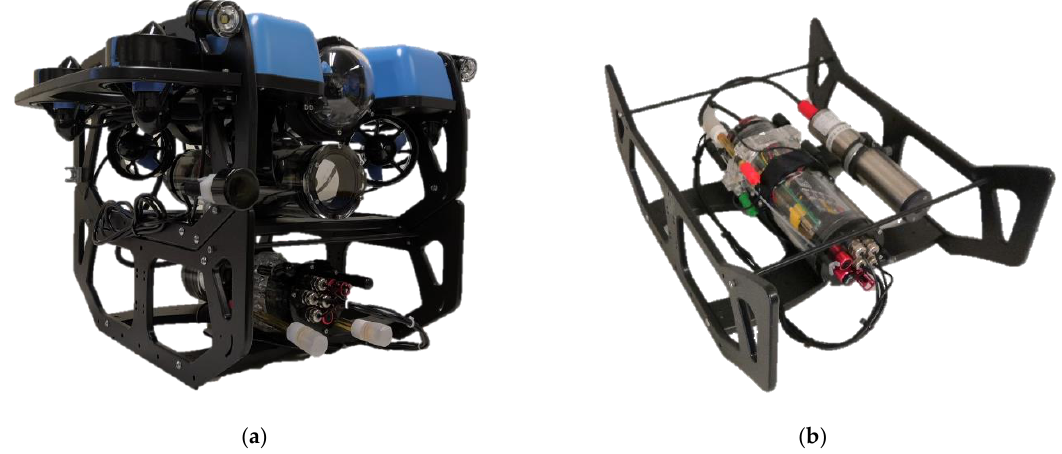
Figure 7. ( a ) BlueROV2 equipped with additional sensors; ( b ) sensor system developed mounted into ROV frame (right). Table 3. Summary of in situ sensor specifications integrated into the multi-sensor system.